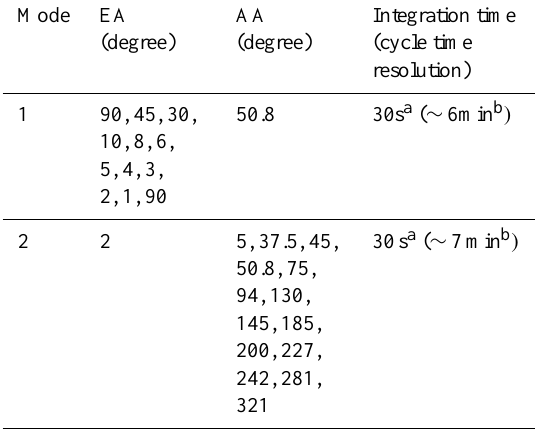
Table 3. List of trace gas references used for the DOAS analysis.